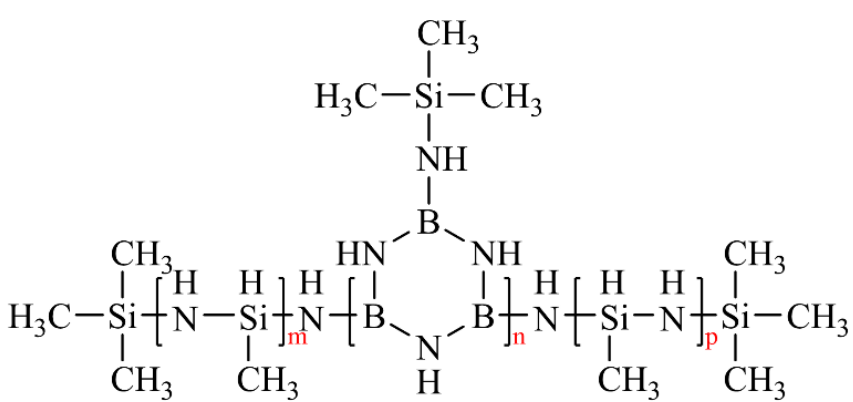
Figure 3. Possible molecular structure of ceramic precursors, and the m, n and p denote random degree of polymerization.